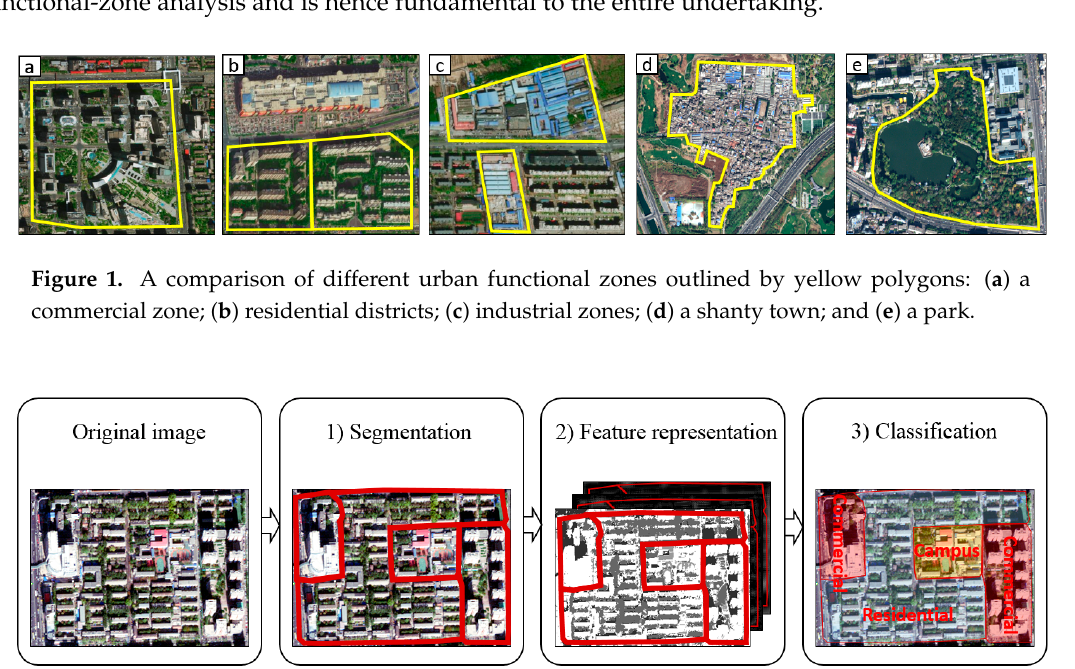
Figure 1. A comparison of different urban functional zones outlined by yellow polygons: ( a ) a commercial zone; ( b ) residential districts; ( c ) industrial zones; ( d ) a shanty town; and ( e ) a park.